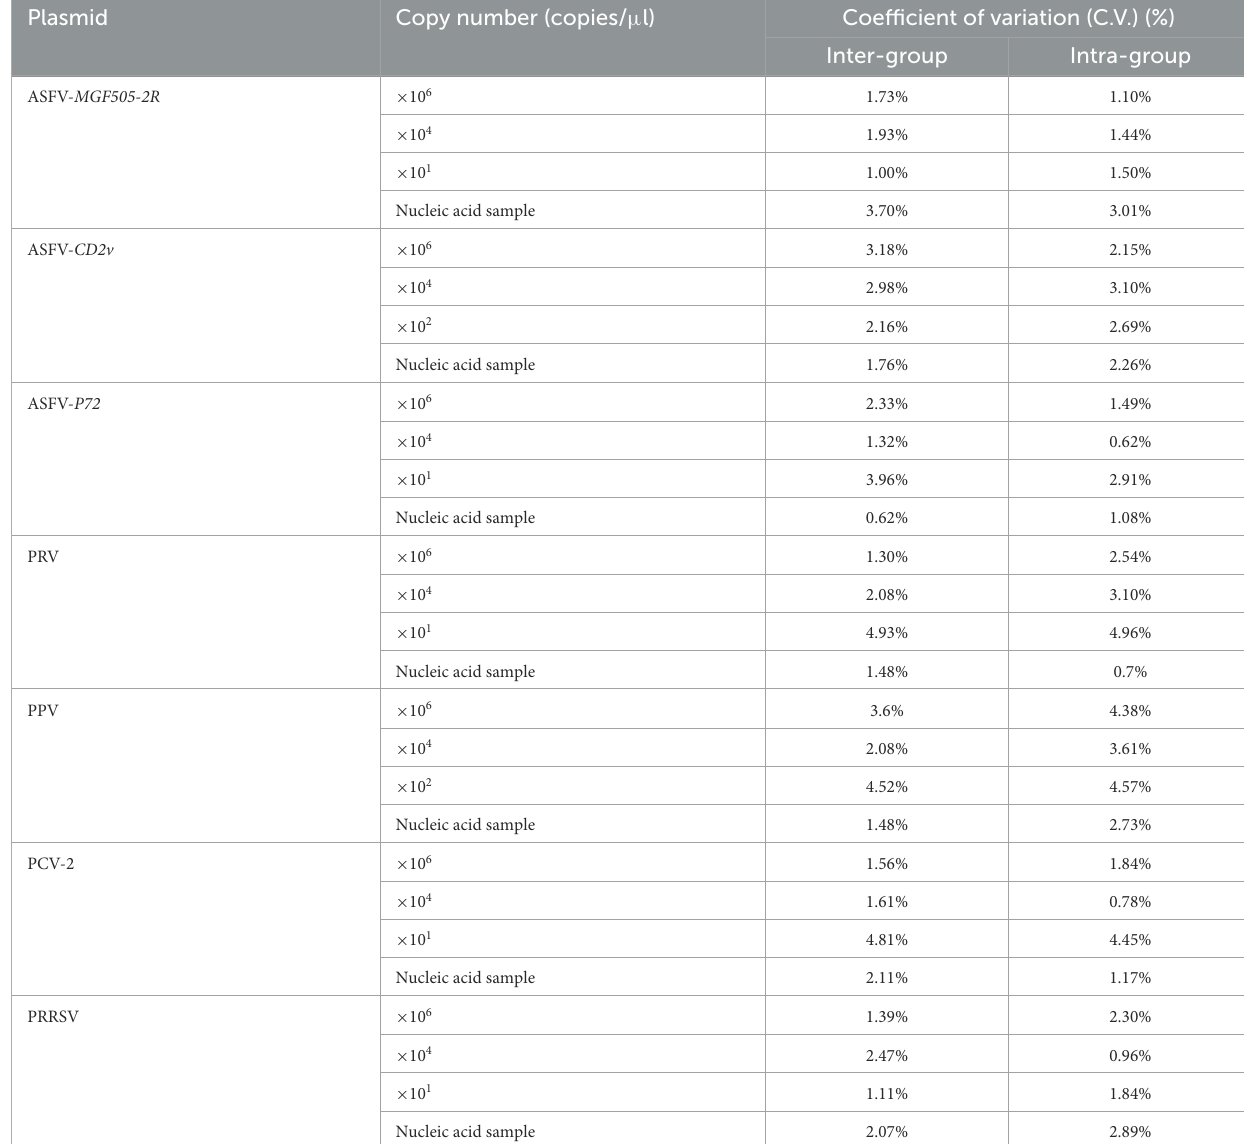
TABLE 2 The SD and C.V. of Tt values for each of eight replicate tests. Plasmid Copy number (copies/ µ l) Coefficient of variation (C.V.) (%)